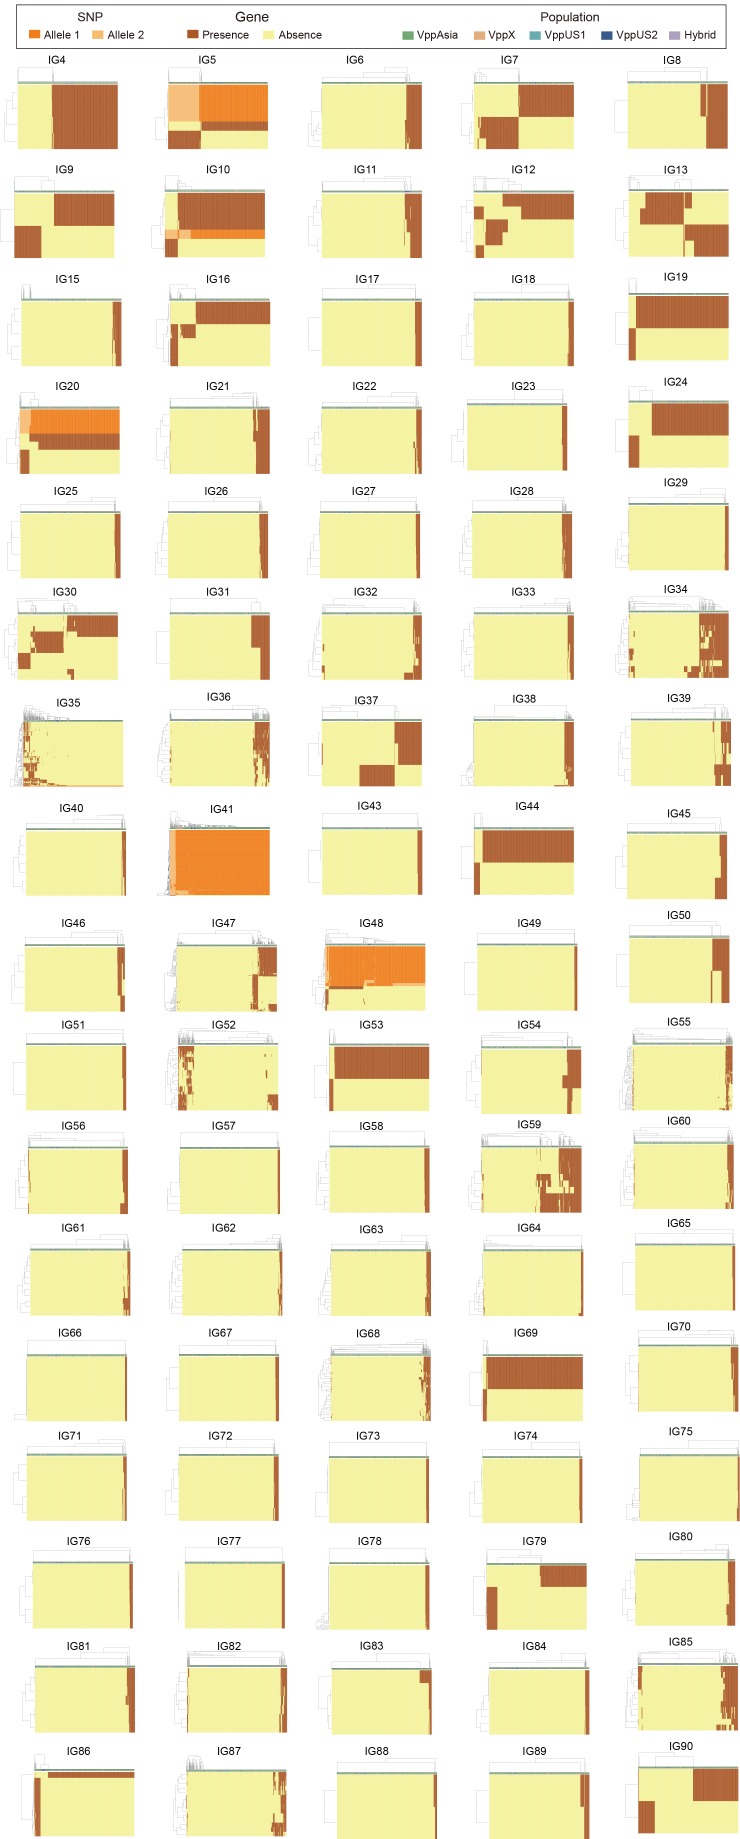
Clustering of 469 strains based on variations of IG2-90.Hierarchical clustering of strains (column) based on coadaptation loci (row) of all IGs, except for IG1, 2, 3, 14, and 42 that had been showed in figures of the main text. Colors of the heatmap indicate the status of genetic variants, colored bars below the upper clustering tree indicate the populations of strains as shown in the legend.